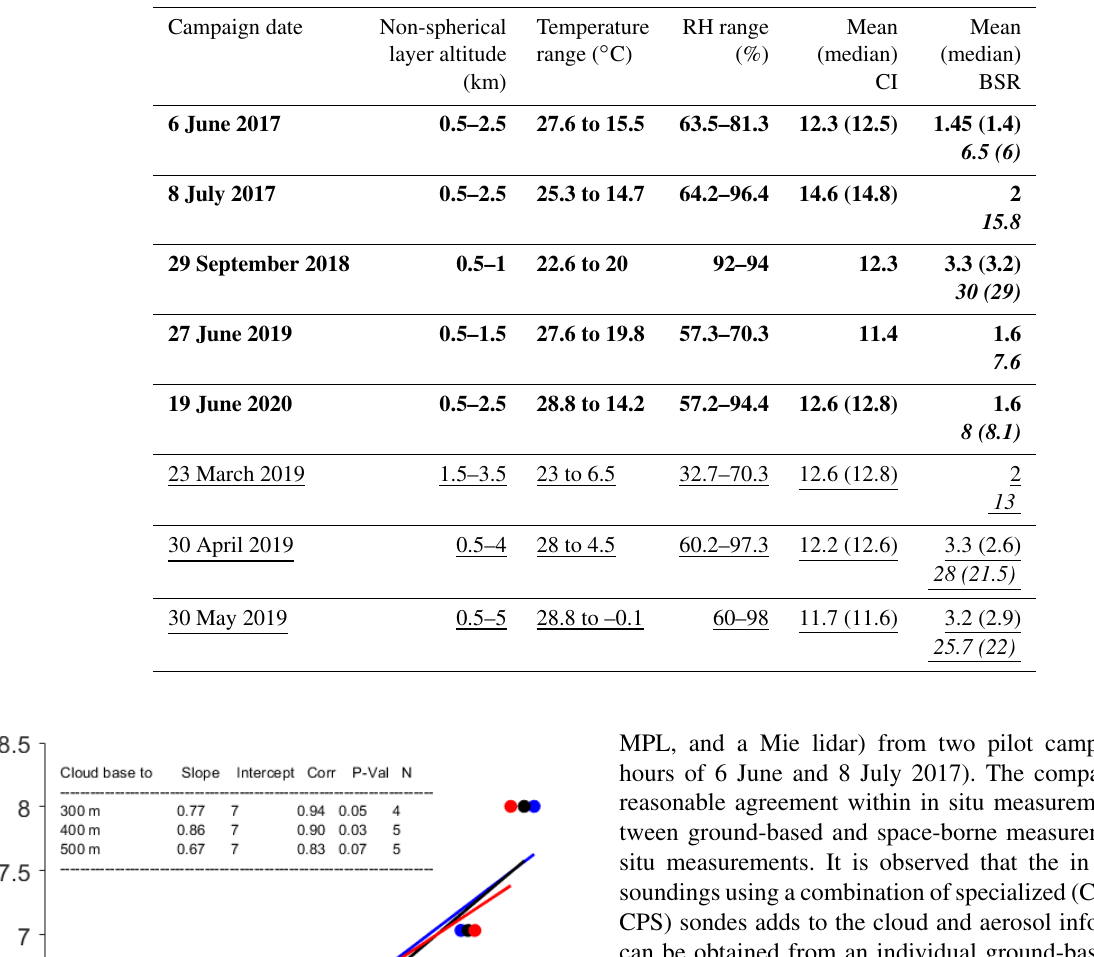
Table 4. Colour index (CI) and backscatter ratio (BSR) of non-spherical (coarse) particle layers as identified by a CPS sonde. The BSR in the roman (italic) font is for 450nm (940nm). Bold (underlined) font values are observed in the monsoon (pre-monsoon) months.